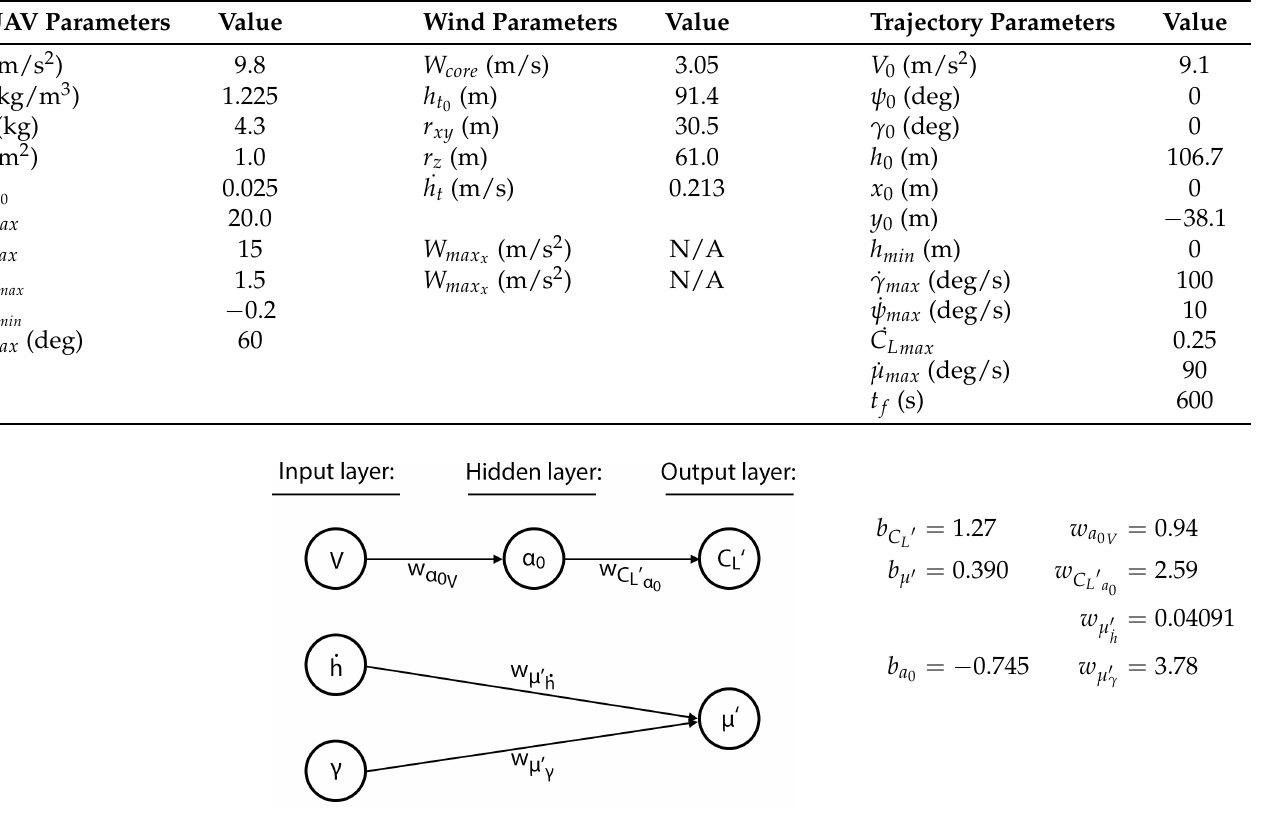
Figure 19. Topology of the thermal soaring SUAV